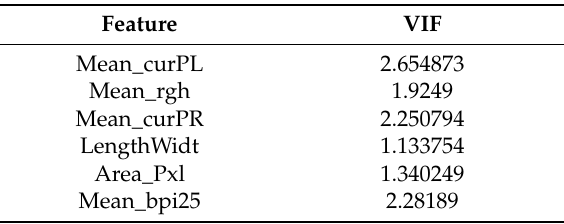
Table 5. Variance inflation factors for the selected